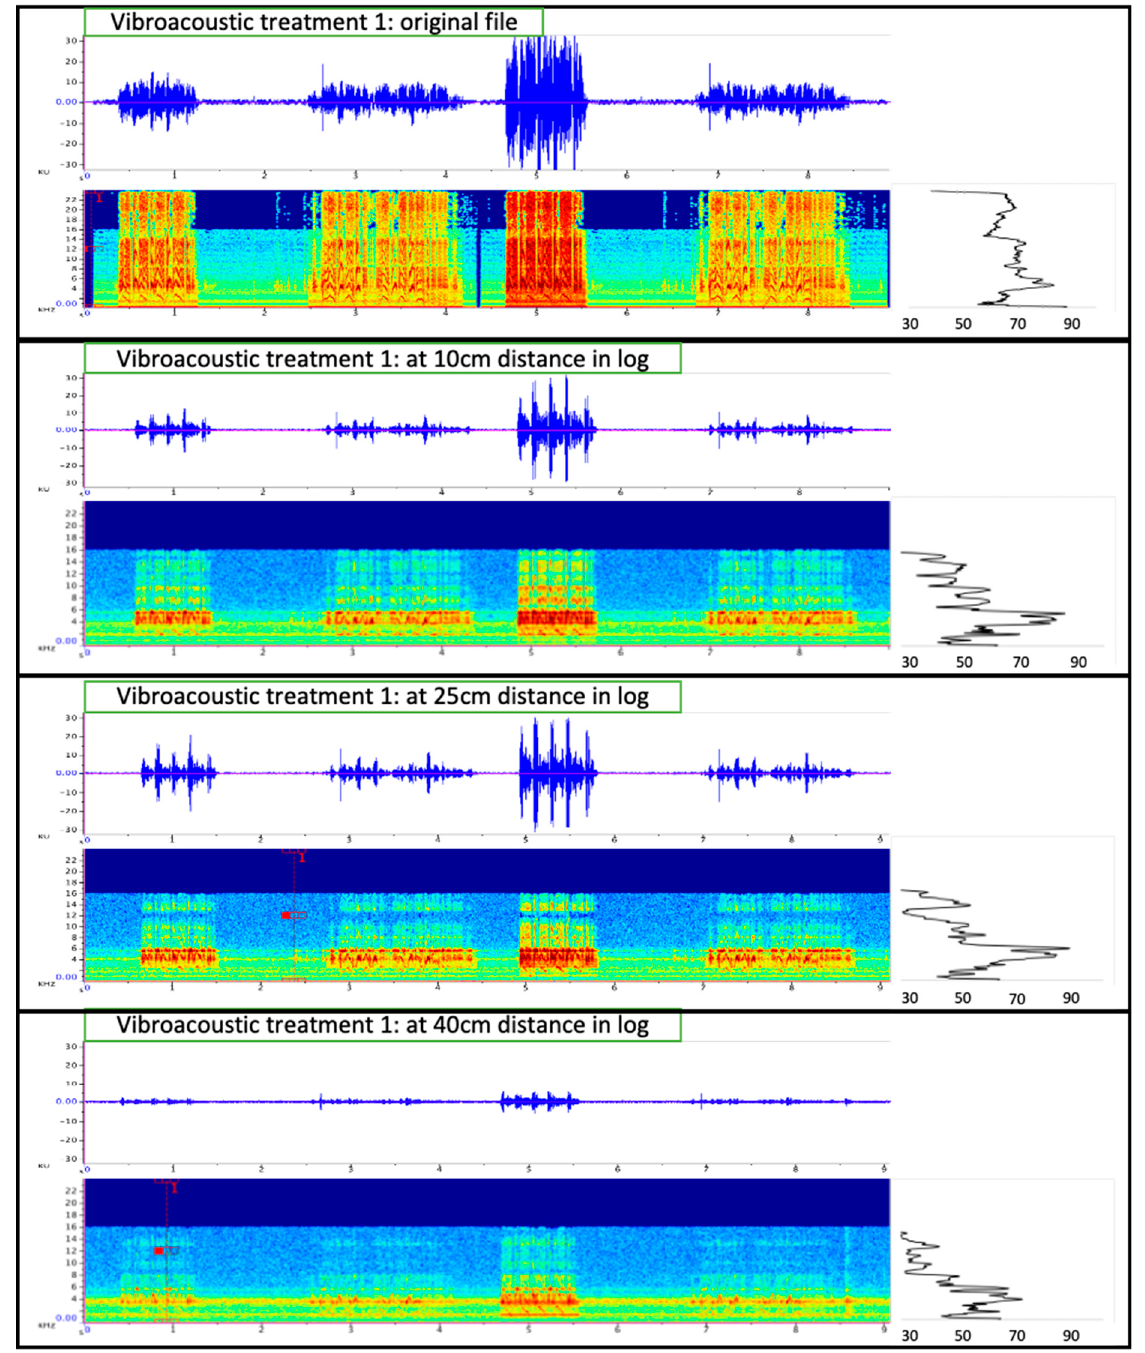
Figure 7. Waveform (top panel: amplitude over time in seconds), spectrograph (bottom panel: kHz over time in seconds) and mean spectrum (right panel, kHz over dB re 20 μ Pa) of vibroacoustic Treatment 1 ( Ips confusus stress call) of original vibroacoustic file (top image set) and recordings of vibroacoustic input in the log at 10 cm, 25, and 40 cm from the speaker.